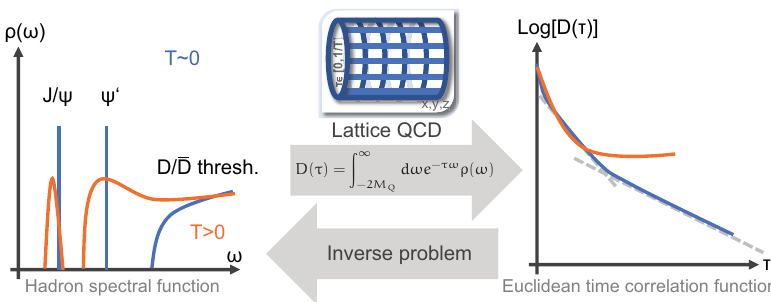
Figure 1. Sketch of the inverse problem using quarkonium as example. We must extract spectral functions ρ from Euclidean lattice simulations, which only produce a noisy and discrete imaginary time correlator D that corresponds to a convolution of the spectral function with a known kernel function K. form of K when considering hadron physics at T = 0 and T > 0 K T = 0 = exp[ − ωτ ]